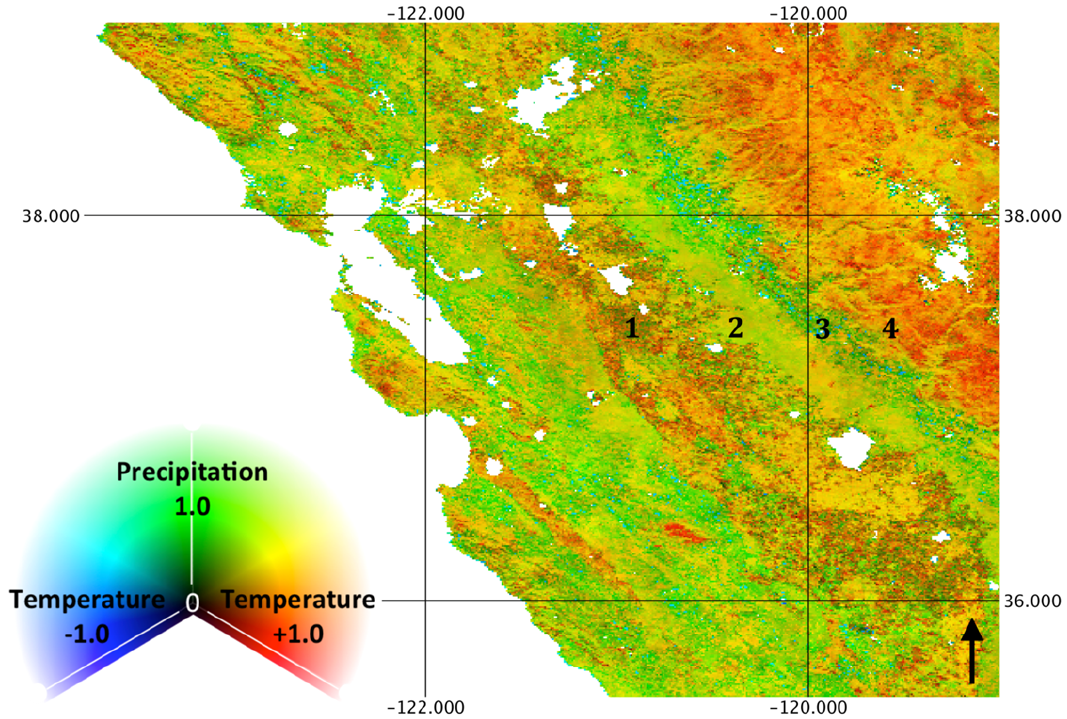
Figure 8. Combined correlations for precipitation (positive) and temperature (positive and negative) illustrating land cover and ecosystem types in the State of California State, USA. 1-km resolution.